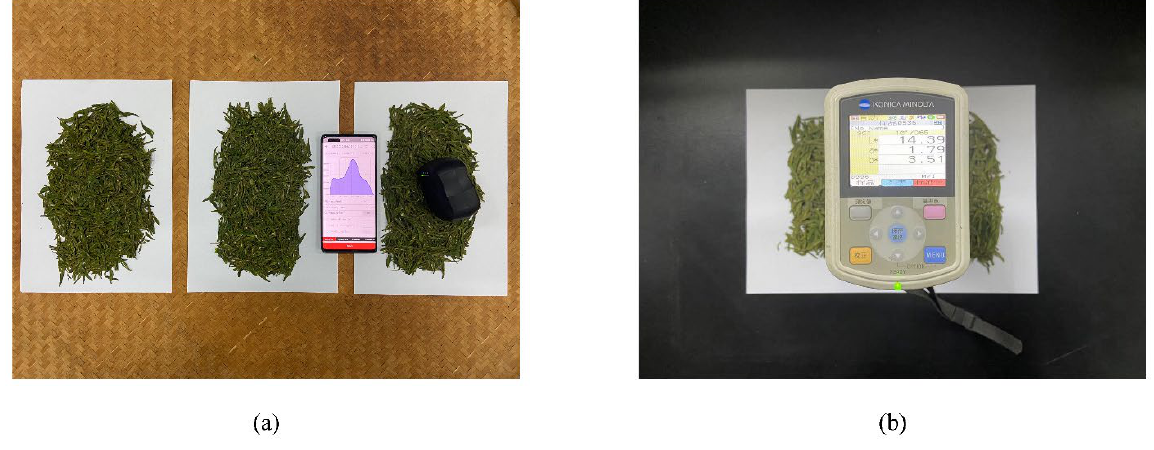
Figure 1. Sensor data acquisition: ( a ) micro-NIR; ( b )colorimeter.